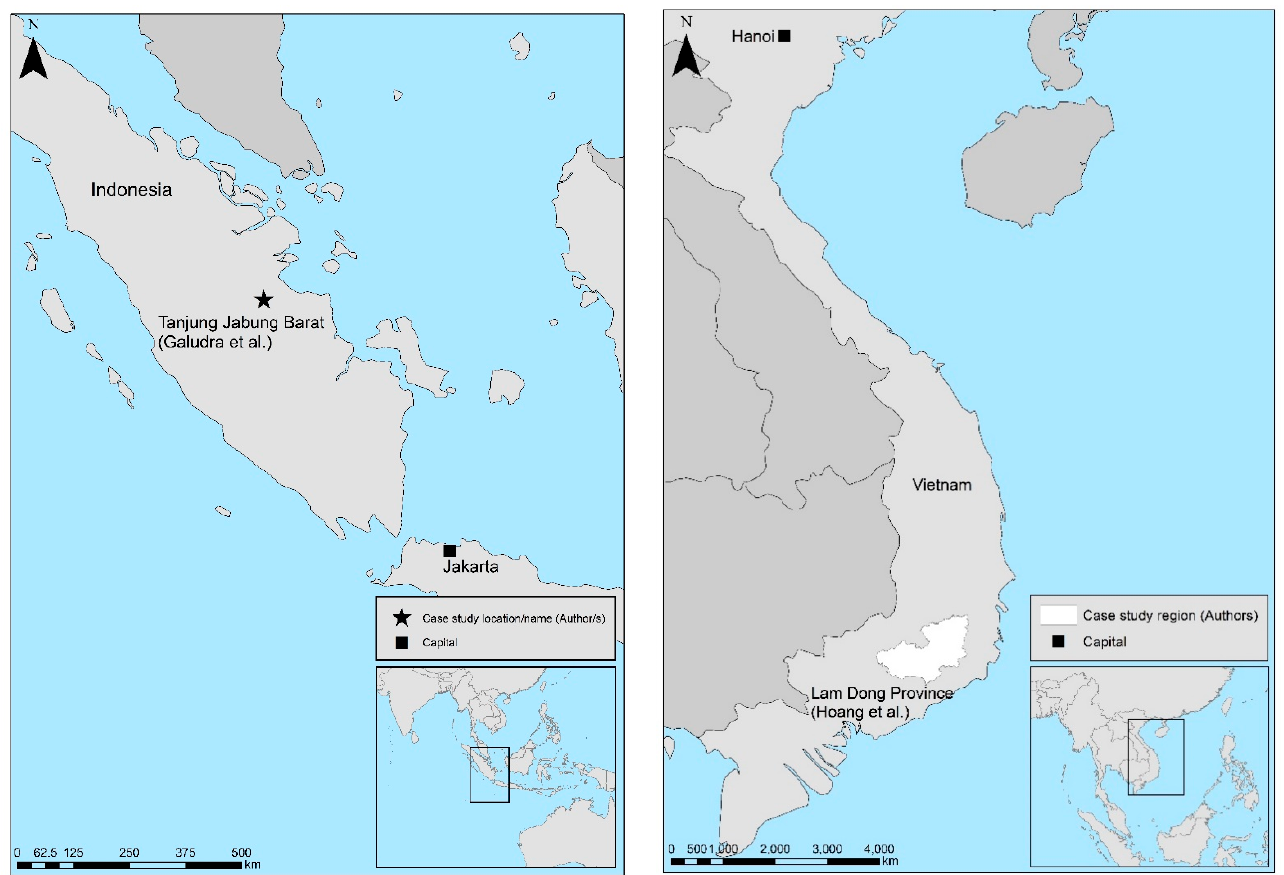
Figure 3. Location of case studies in Southeast Asia (Syed Zulfiqar Ali Shah for the authors, based on [30,32]).